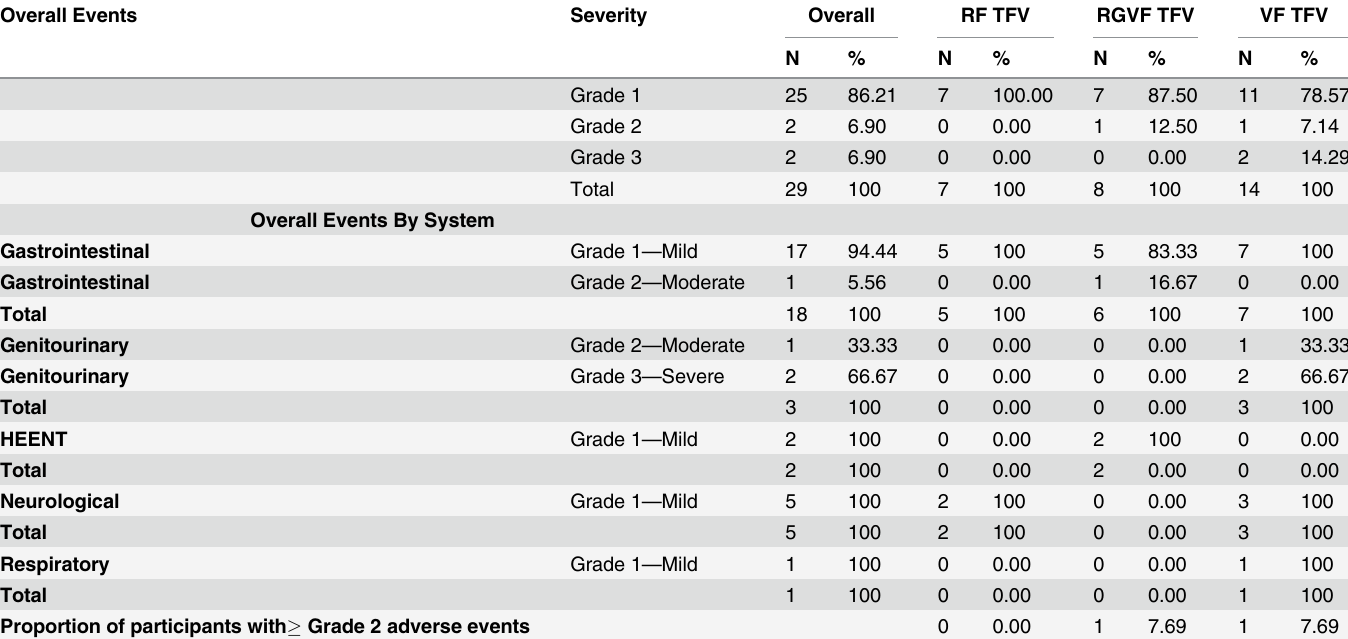
Table 2. Adverse events by